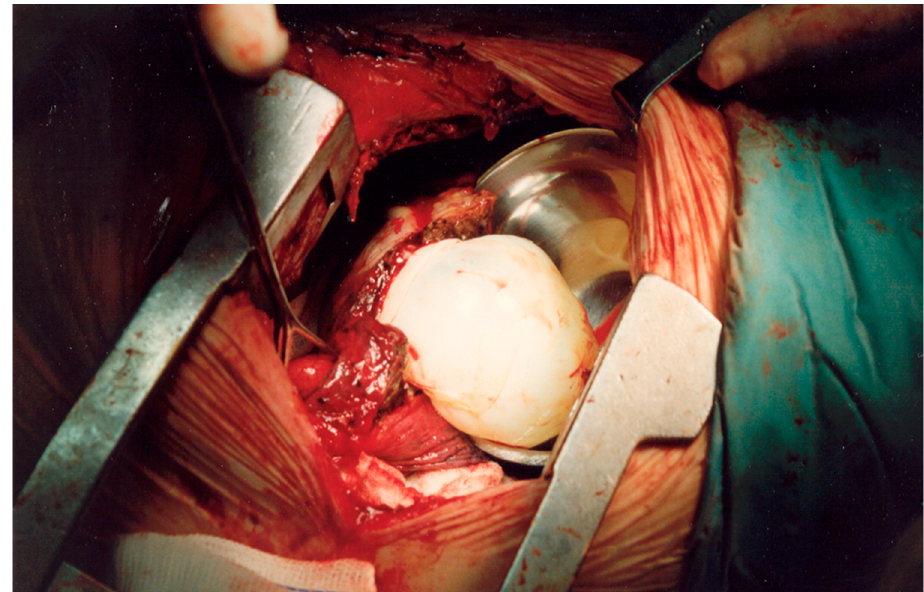
Figure 10. An intraoperative image of patient 3. For a large-sized cyst which is not suitable for excision by endostaplers, it is better to dissect it from the surrounding parenchyma, avoiding rupture to prevent anaphylaxis or reinfection. A collecting pot is preemptively next to the cyst to prevent accidental spillage of contents to the pleural cavity.